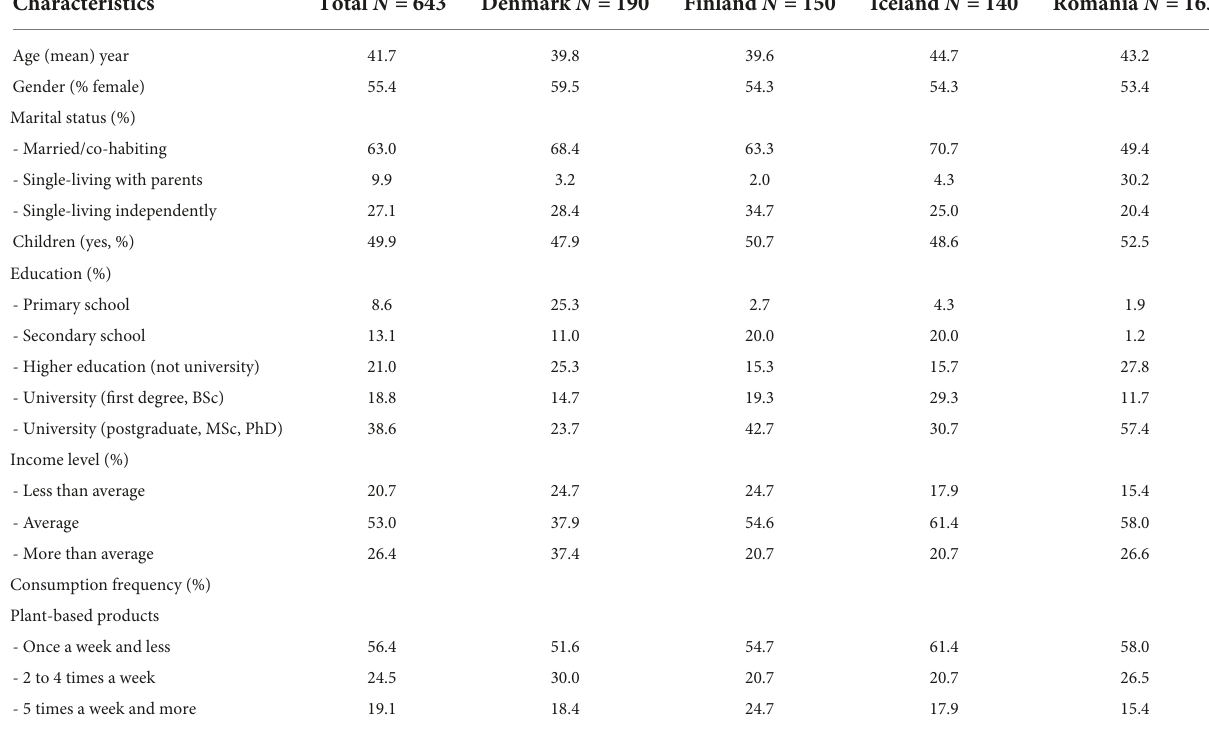
TABLE 1 Sociodemographic characteristics of the participants. Characteristics Total N = 643 Denmark N = 190 Finland N =